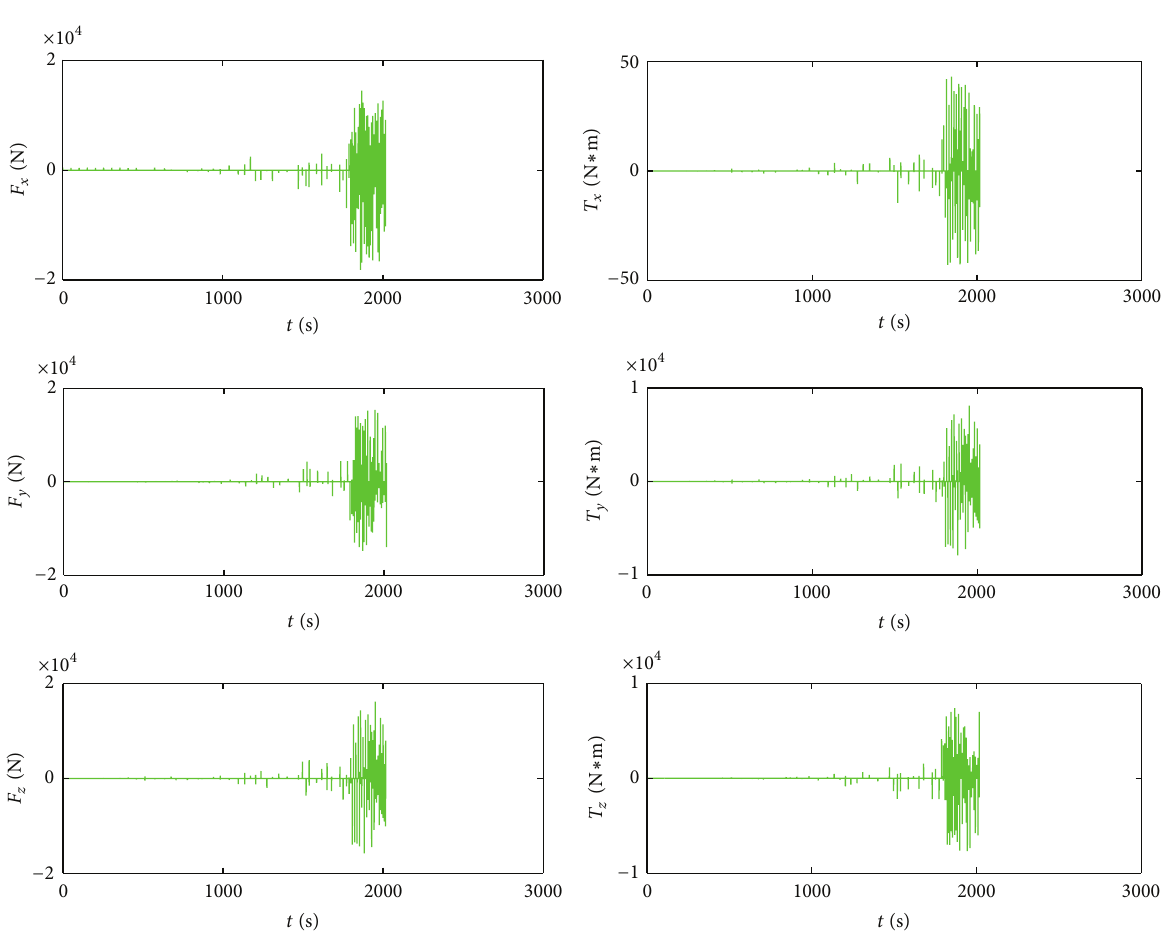
Figure 20: The components of the tension force ( 𝐹 𝑥 , 𝐹 𝑦 , and 𝐹 𝑧 ) and the disturbing torque ( 𝑇 𝑥 , 𝑇 𝑦 , and 𝑇 𝑧 ) in 𝜋 𝐴 caused by the tether.